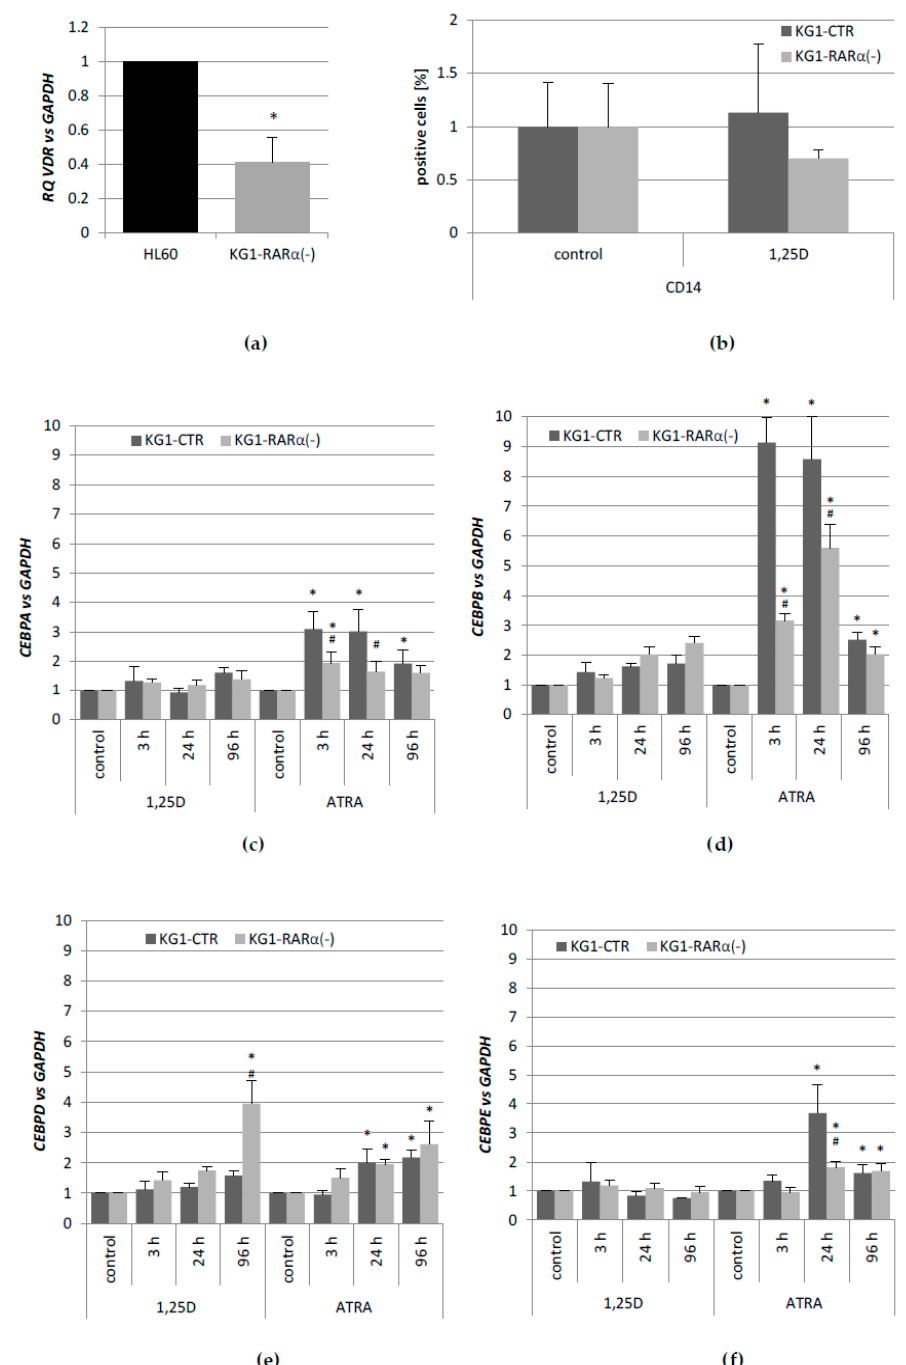
Figure 3. Responses to 1,25D and to ATRA in KG1 cells with silenced retinoic acid receptor α ( RARA ) gene. Expression of vitamin D receptor ( VDR ) gene in KG1-RAR α ( − ) cells compared to HL60 cells, which were treated as calibrator ( a ). Differentiation of KG1 sublines in response to 1,25D. KG1-CTR and KG1-RAR α ( − ) cells were stimulated with 10 nM 1,25D for 96 h and then the expression of CD14 differentiation marker was detected using flow cytometry ( b ). Expression of CEBPA ( c ), CEBPB ( d ), CEBPD ( e ), and CEBPE ( f ) genes in KG1-CTR and KG1-RAR α ( − ). Cells were stimulated with 10 nM 1,25D or 1 µ M ATRA and after desired time the expression of CEBP genes was measured by Real-time PCR. The bars represent mean values of the fold changes ( ± SEM) in mRNA levels relative to GAPDH mRNA levels. Expressions in control cells were treated as calibrators. Values that are significantly different from those obtained from respective controls cells are marked with asterisk (* p < 0.05); values that differ significantly from those obtained from respective KG1-CTR control cells are marked with hash (# p < 0.05).